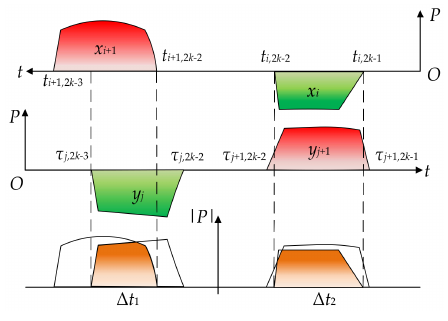
Figure 3. Flow of energy consumption and regenerative braking energy.